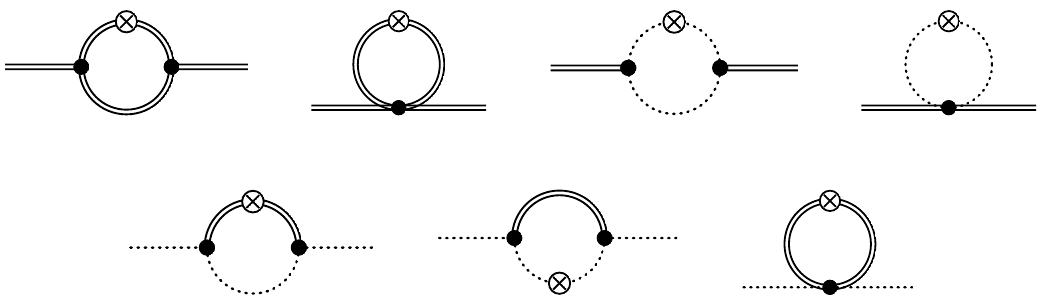
Figure 1 . Diagrammatic representation corresponding to the r.h.s. of eq. (3.1). The (cid:12)rst row correspond to the (cid:13)ow of the graviton 2-point function (cid:14) 2 (cid:0) k =(cid:14)h 2 . In the second row we include diagrams representing the (cid:13)ow of the ghost 2-point function (cid:14) 2 (cid:0) k =(cid:14)c(cid:14) (cid:22) c . The double-line style correspond to the graviton, while the Fadddeev-Popov ghosts are represented by dotted lines. The running for the corresponding dimensionless mass parameters ( ~ m 2 obtained by the simple formula @